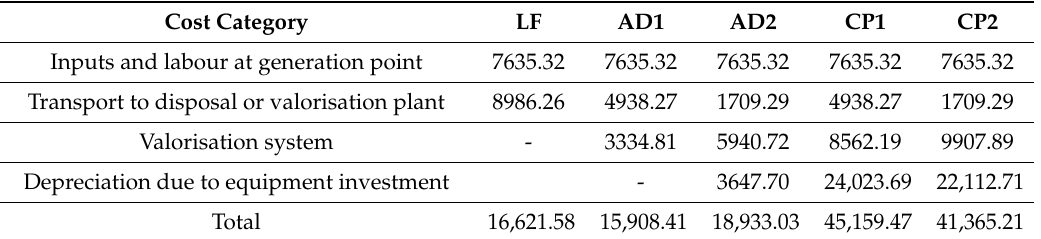
Table 5. Cost of the business as usual and alternative FW treatment scenarios, expressed in USD. Cost Category LF AD1 AD2 CP1 CP2 Inputs and labour at generation point 7635.32